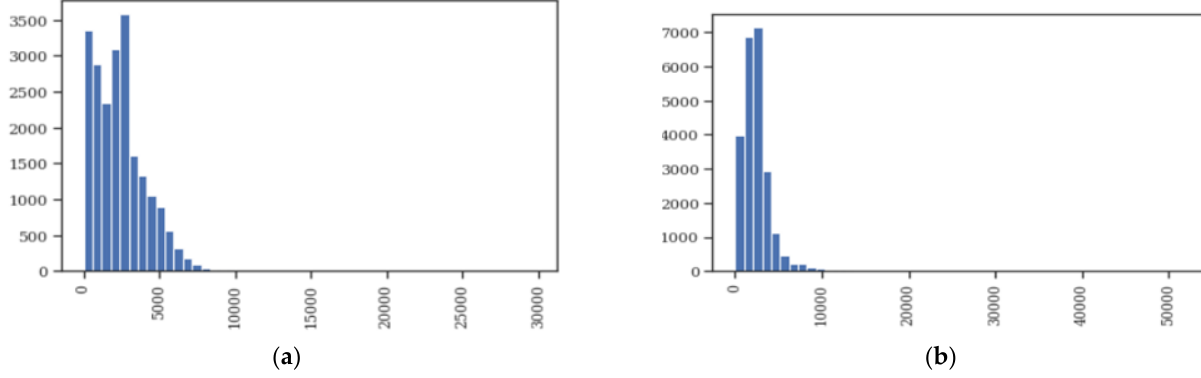
Figure 8. Text length with counts of real and fake news; ( a ) real news text length counts; ( b ) fake news text length counts.